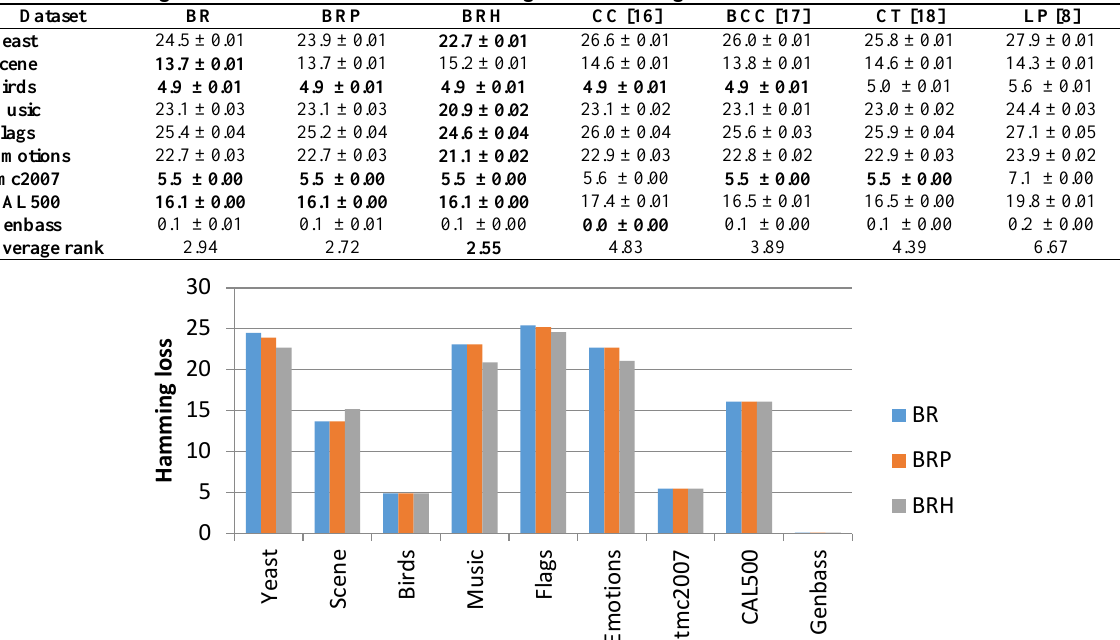
Figure 1. Effect of using positive and hybrid association rules on BR performance measured by hamming loss. Smaller values represent a better